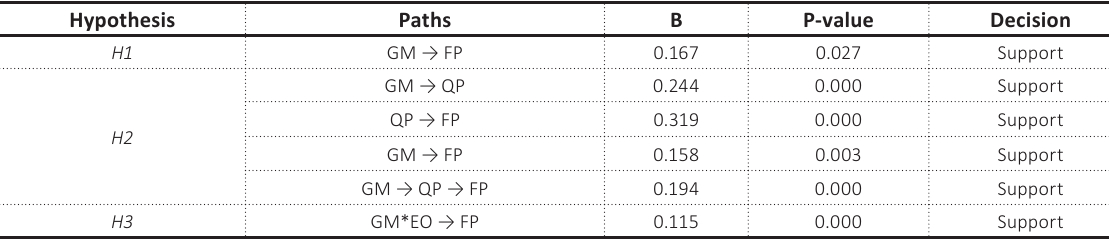
Table 2. Inner model estimates for hypotheses